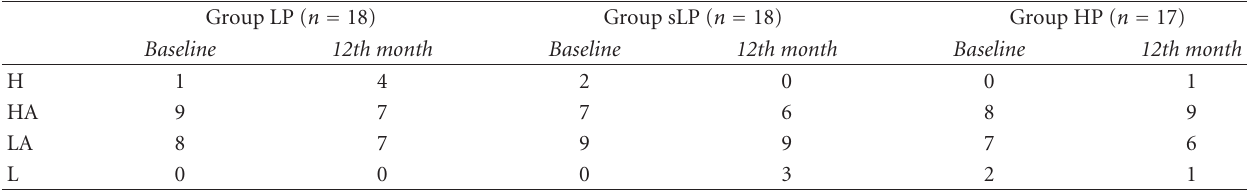
Table 2: Comparison of peritoneal transport rate distribution classified by D/P cr among the 3 groups at baseline and 12th month.